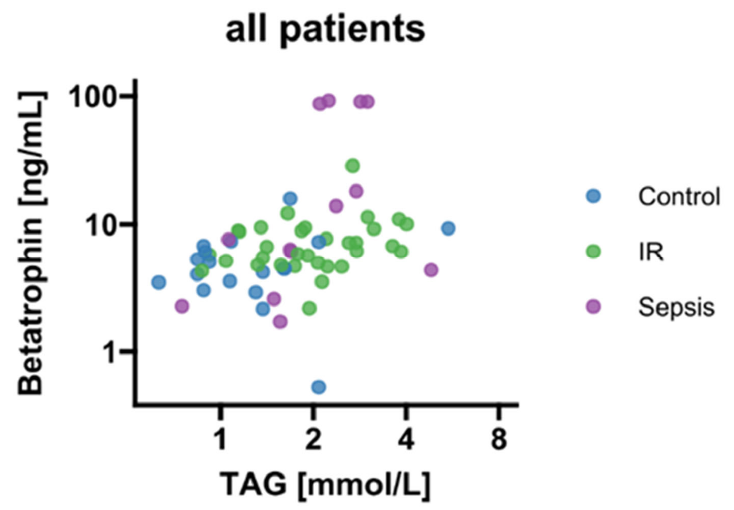
Figure 3. Correlation analysis of circulating betatrophin/ANGPTL8 and TAG (r = 0.46; p < 0.001). IR, insulin resistance; TAG, triacylglycerides.